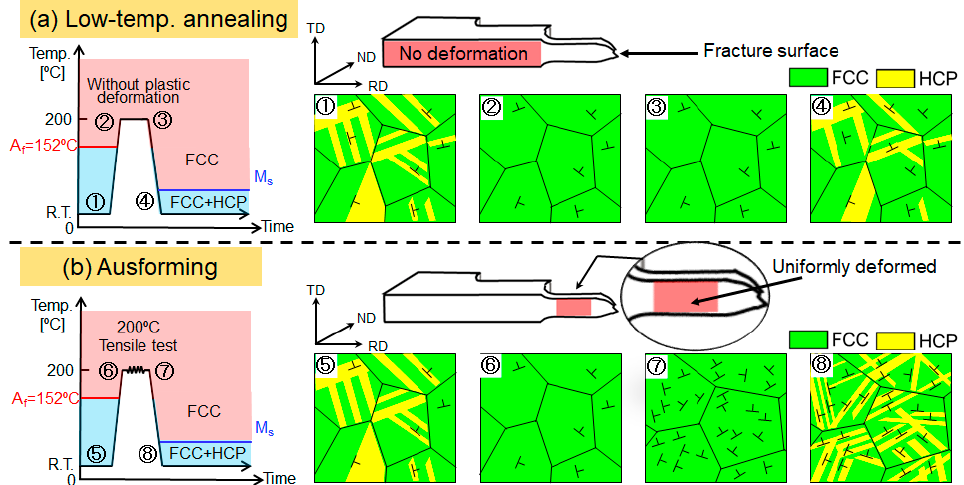
Figure 4. Schematic diagrams of the heat treatment history and expected microstructures for ( a ) low-temperature annealing and ( b ) ausforming. Highlighted regions in the schematic illustration of the fractured specimens indicate the targets of the present observations.